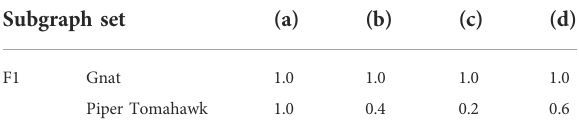
TABLE 5 F1 (comparison) scores for the four maximum common subgraphs. Subgraph set